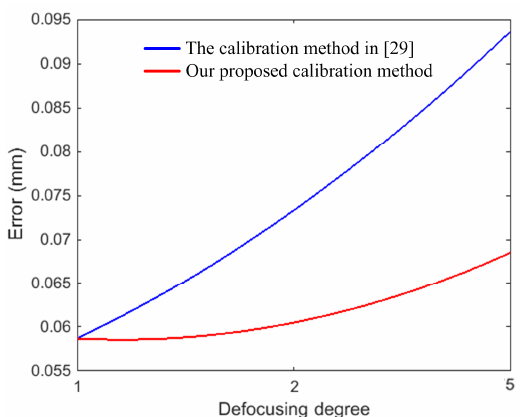
Figure 21. Measurement error of the hemisphere under different defocusing degrees using our